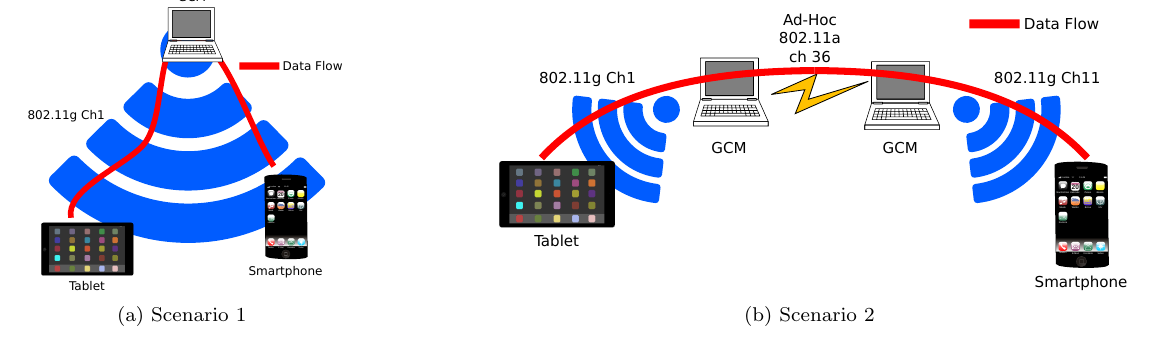
Figure 4: Scenarios used in our experiments. Table 1: Devices